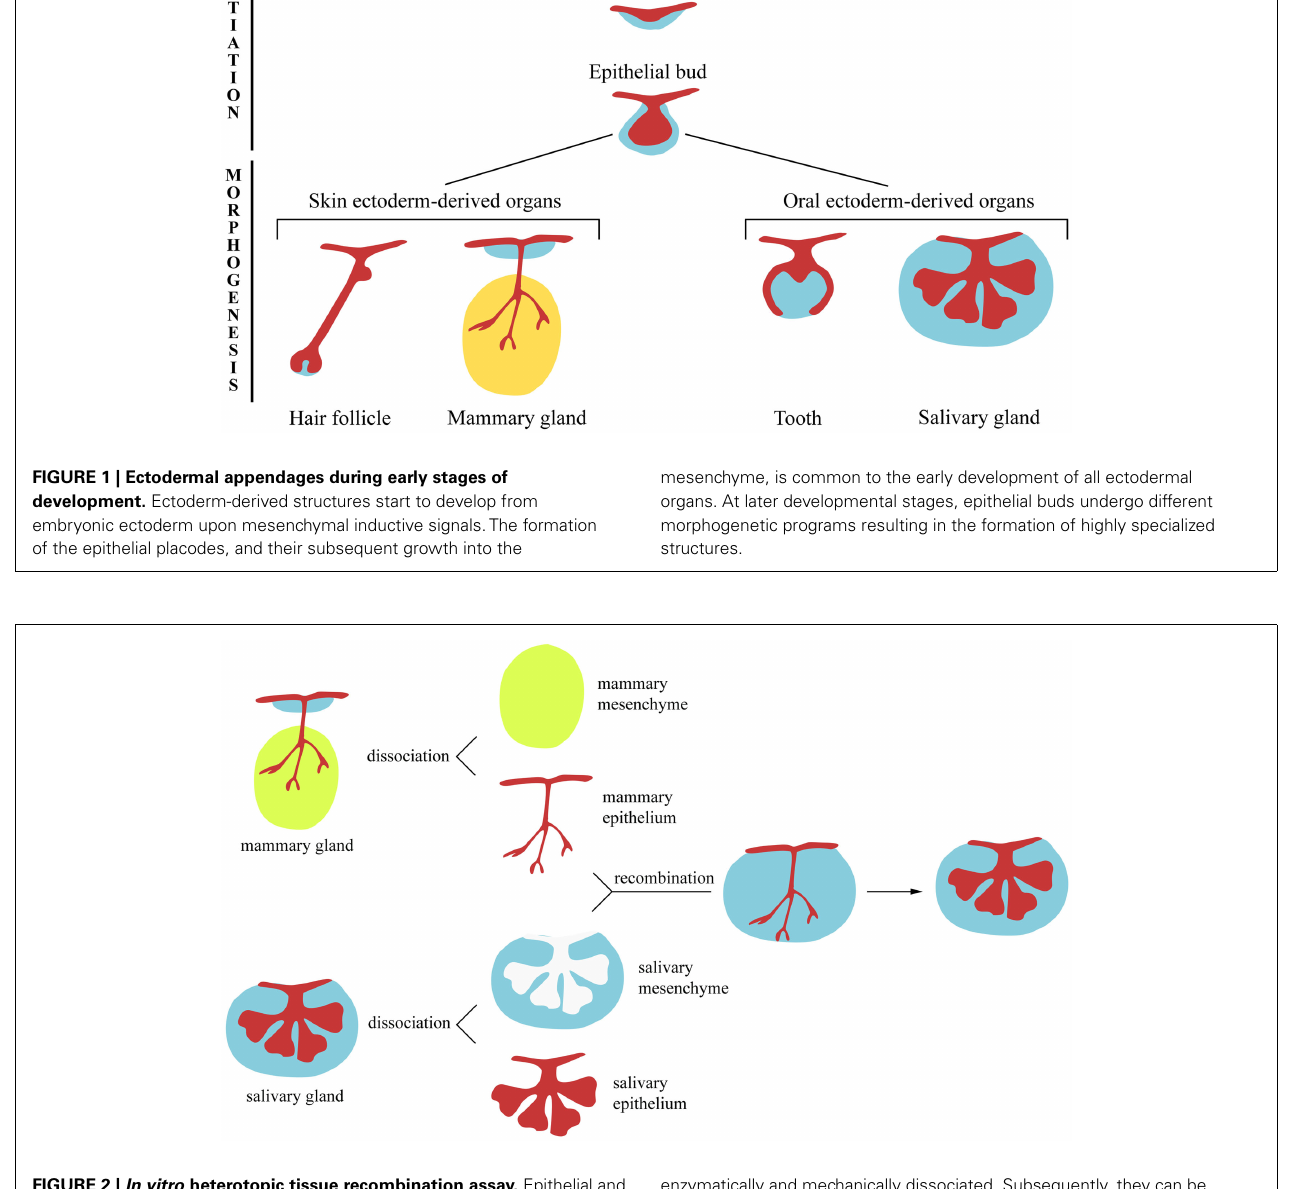
enzymatically and mechanically dissociated. Subsequently, they can be recombined with epithelium and mesenchyme from a different